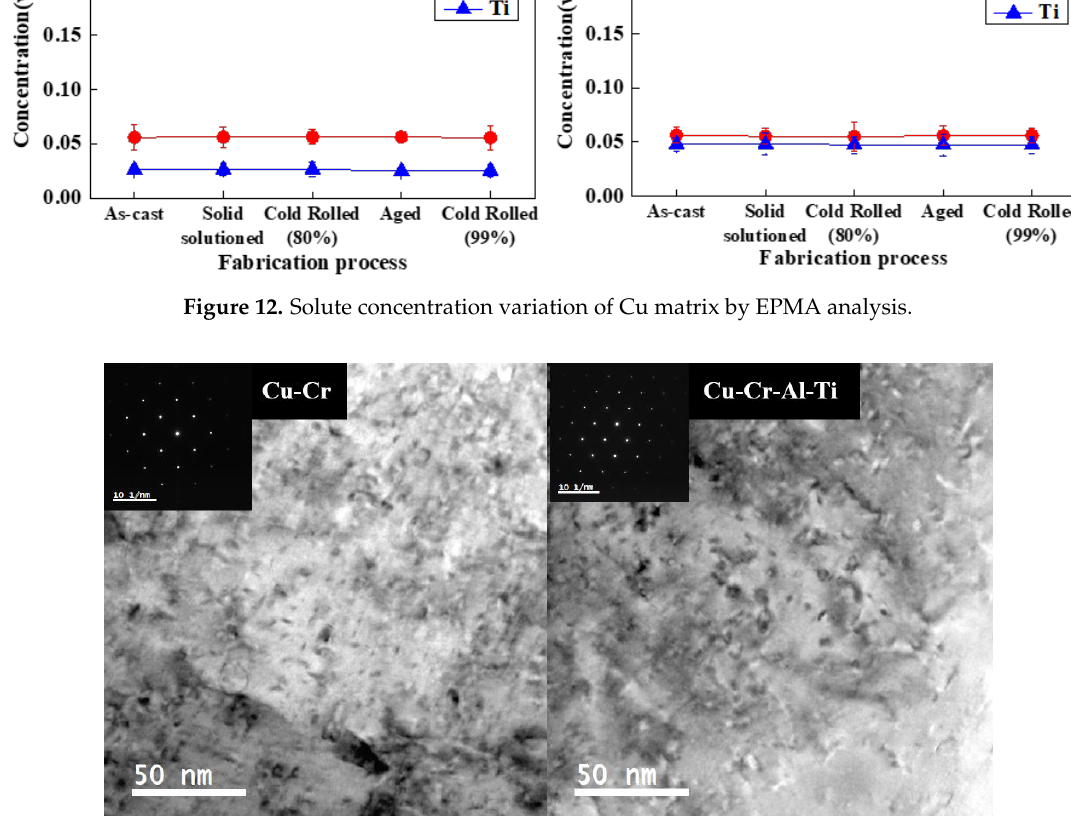
Figure 13. TEM images and diffraction pattern of Cu-Cr and Cu-Cr-Al-Ti alloys after solid solution heat treatment.